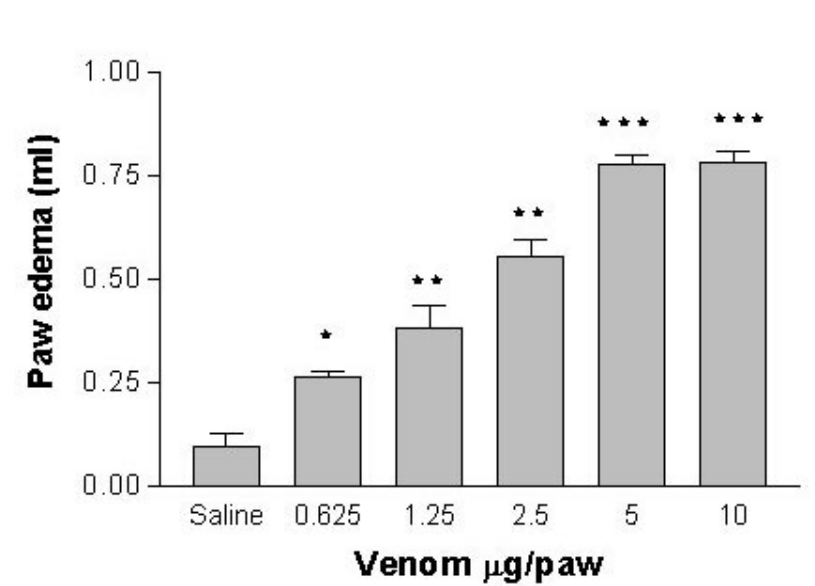
Figure 1A : Intensity of the rat paw edema induced by NhaV varying according to different doses (0.625–10µg/paw) of venom. The control group received saline (0.1ml) in the same experimental conditions. Each column represents the mean ± S.E.M. of six rats.